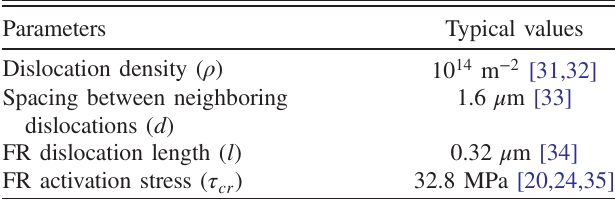
TABLE II. Summary of annealed OFHC Cu microstructural parameters used to model RSS behavior during step